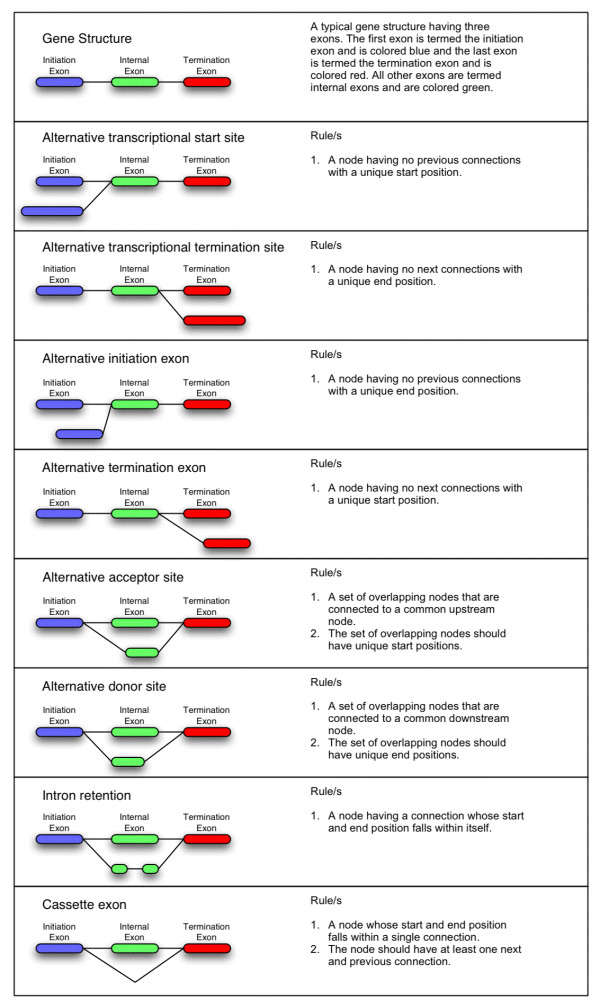
Rules used to classify splicing graphs in DEDB. Initiation, internal and termination exons are colored blue, green and red respectively. Each of the type of alternative splicing event and gene structure event is depicted as a single boxed row. Within each boxed row, a graphical illustration of the gene structure is shown on the left together with the textual rules on the right.